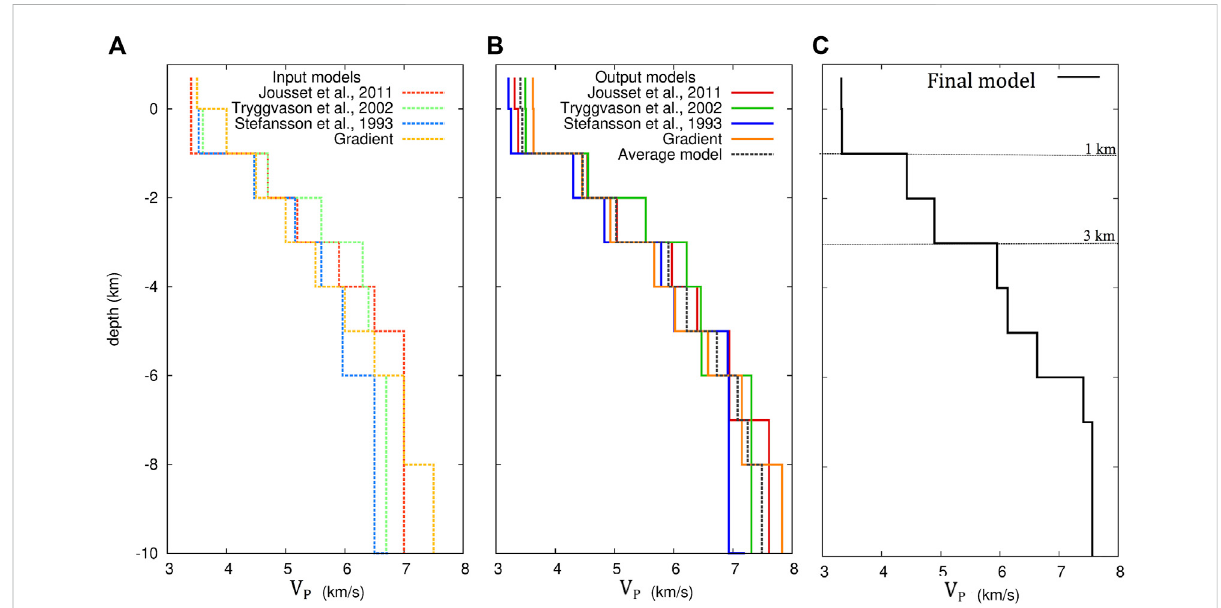
FIGURE 3 1D-velocity model analysis. (A) Velocity models available in literature for the Hengill area (Stefánsson et al., 1993; Tryggvason et al., 2002; Jousset et al., 2011) used as starting models in VELEST. A fourth synthetic gradient model has been used to test the stability of the results. (B) The 1D velocity models (whole lines) obtained using 473 events from the study area. A fi nal 1D velocity model has been obtained (dashed black line) averaging the velocity in each layer up to a depth of 10 km. This model has been used as input in VELEST. (C) Minimum P-wave 1D velocity model speci fi c for the study area, the Nesjavellir geothermal area and